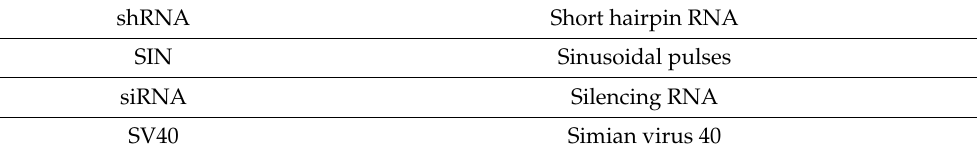
Table 1. Cont. shRNA Short hairpin RNA SIN Sinusoidal pulses siRNA Silencing RNA SV40 Simian virus